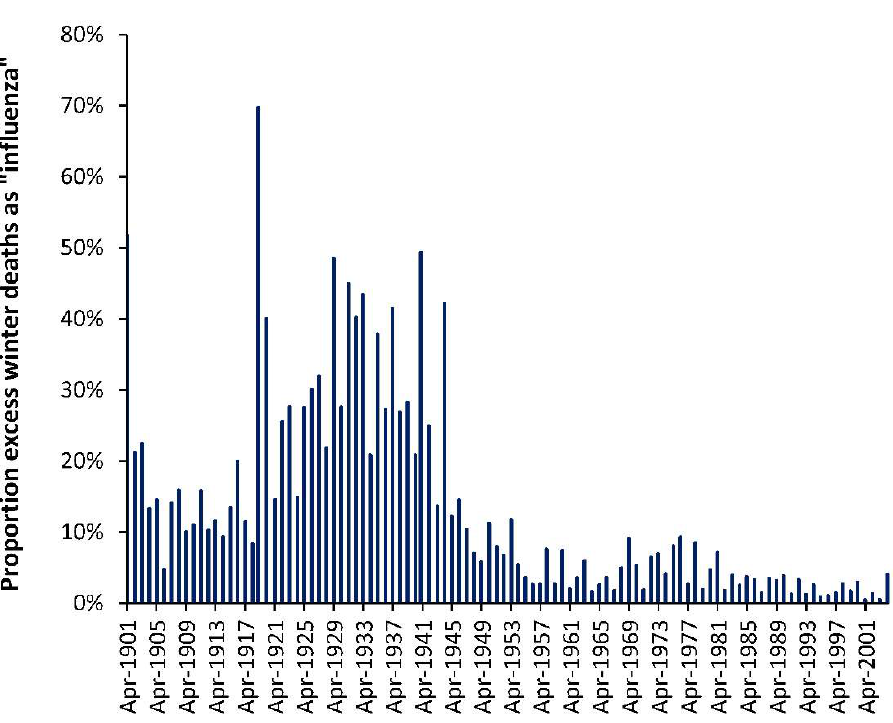
Figure A2. Proportion of excess winter deaths (EWD) recorded as “influenza” (ICD codes J10 and J11). Data is from the study of Doshi [11]. Coding practice seem to have changed from 1977 onward and the proportion after this date has been multiplied by 1.8 to compensate.